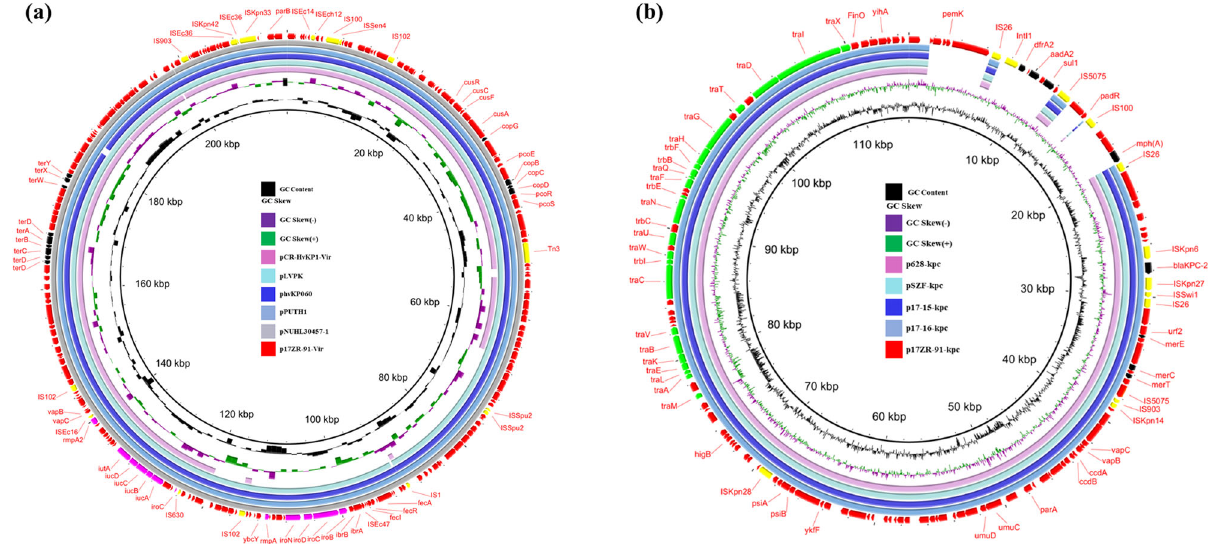
Fig. 2 Circular alignment of virulence plasmid p17ZR-91-Vir and bla KPC-2 -bearing plasmid p17ZR-91-KPC recovered from K. pneumoniae 17ZR-91 with similar plasmids in the NCBI database, respectively. a Alignment of virulence plasmid p17ZR-91-Vir with pLVPK (AY378100), phvKP060 (CP034776), pPUTH1(CP024708), and pNUHL30457-1(CP026587.1) using BRIG. b Alignment of bla KPC-2 -bearing plasmid p17ZR-91-KPC with p628-kpc(NC_032103), pSZF-KPC (MH917122), p17-15-KPC (MK183753), and p17-16-KPC(MK191023)